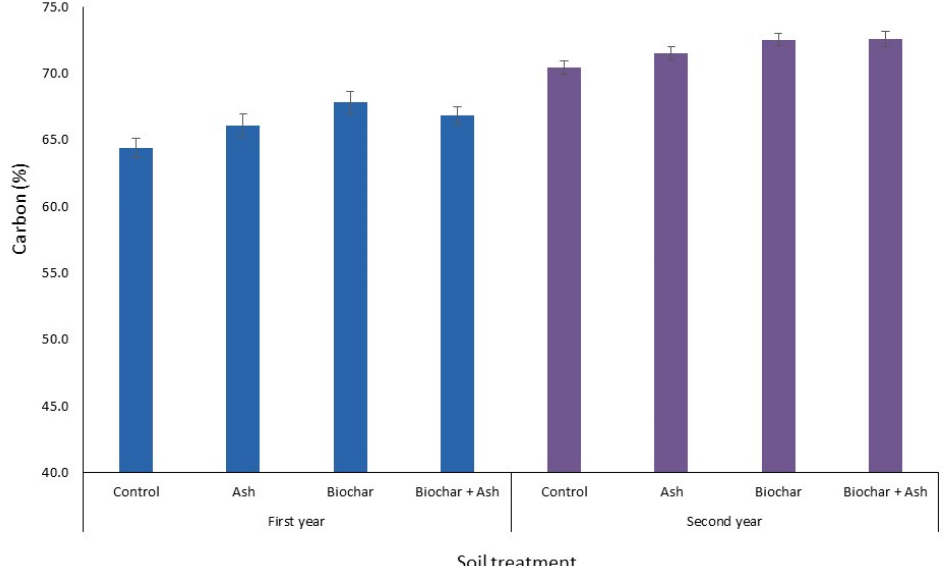
Figure 4. Pyrolysates’ carbon contents, produced from giant miscanthus biomass collected from the control, ash, biochar, and biochar + ash soil treatment plots, one and two years after planting ( n = 12). In accordance with the result of the Bonferroni test, the carbon values were not significantly (α ≤ 0.05) different among treatments (separate comparison for each year).